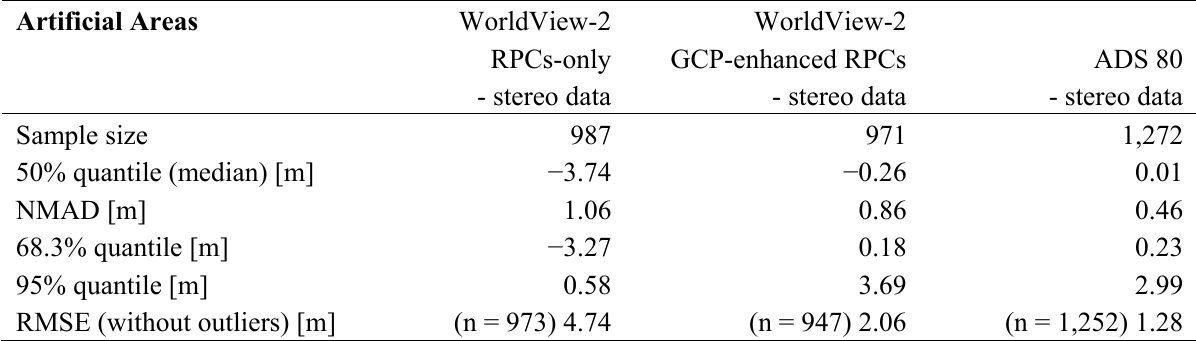
Table 6. Artificial areas. Vertical agreement measures of the three digital surface models in comparison with the